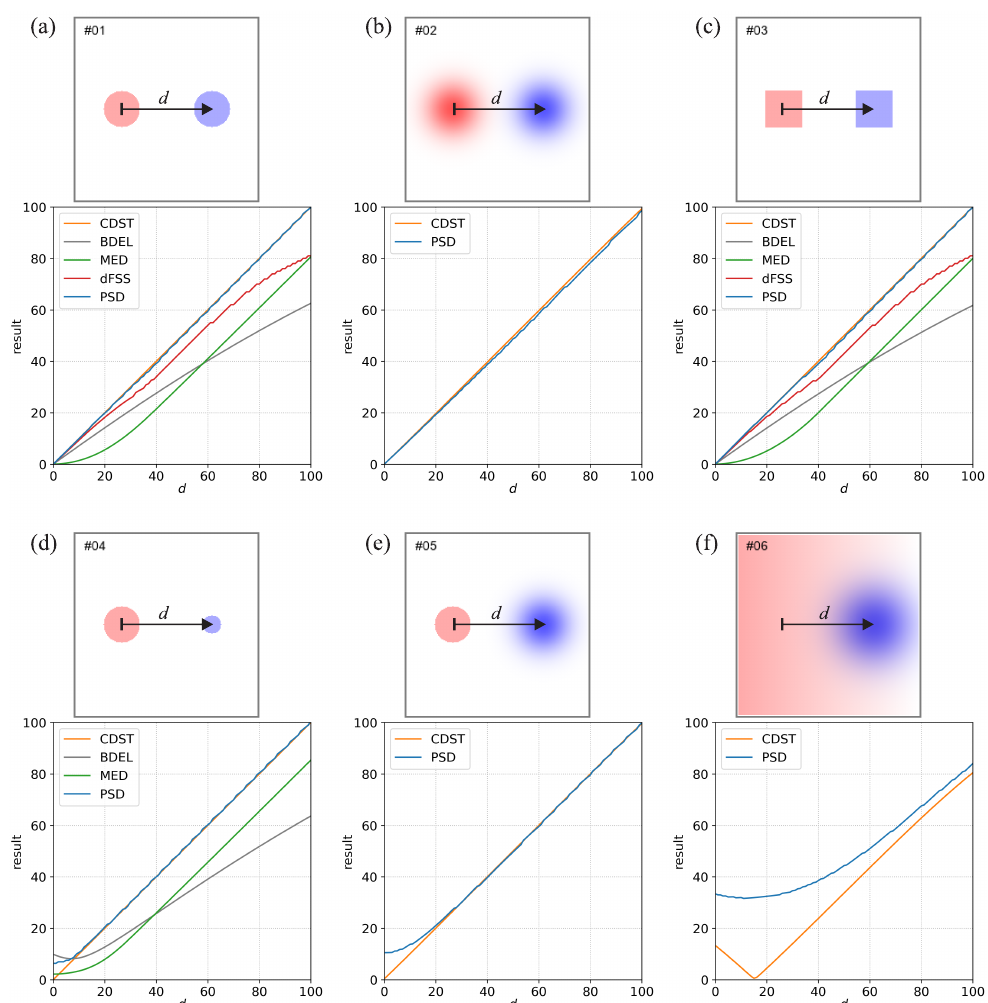
Figure 1. The subfigures ( a – f ) show six idealized situations that were used to analyze the behavior of the distance measures. The top panel in each subfigure shows the layout of the idealized situation. The blue color corresponds to the values in the first field, and the red color corresponds to the values in the second field. The higher the value, the darker the respective color. The arrow marked with d shows the displacement of the event it is pointing to. For example, for d = 0, the blue circular event in ( a ) will completely overlap the red event, while for d > 0, the blue event is moved toward the right. The bottom panel in each subfigure shows the results of the distance metrics. Since the results depend on the d , they are provided for values ranging from 0 to 100 grid-points. If the value of a certain metric is undefined, its results are not shown (e.g., the input fields are non-binary, but the metric can only be used with binary